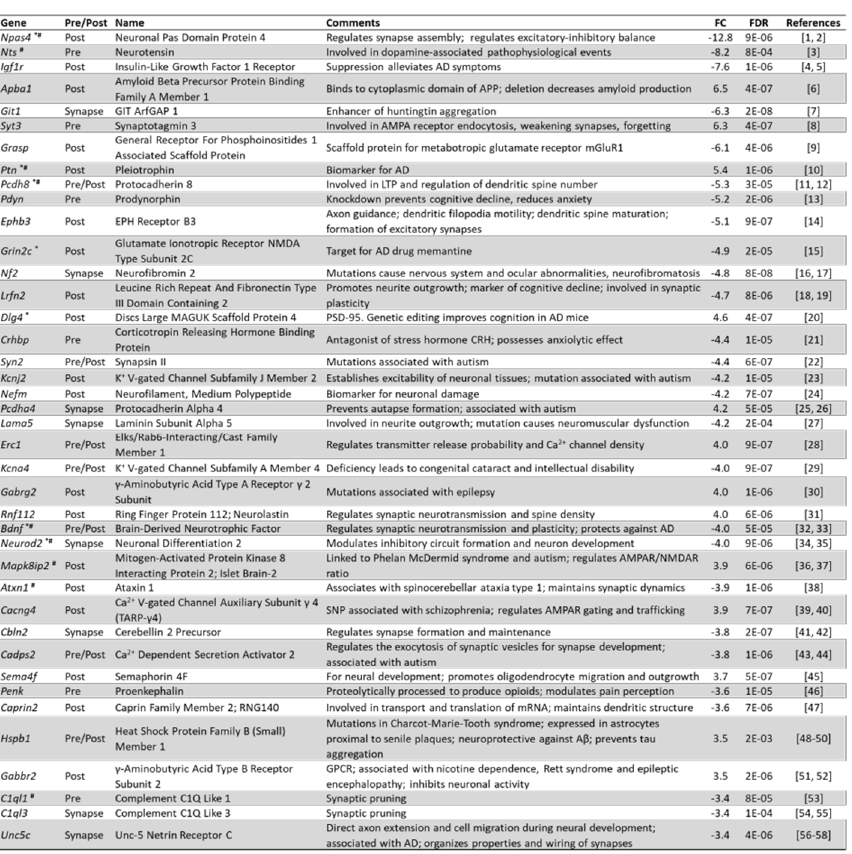
Figure 9. Synaptic genes whose expression is regulated by Arc. Shown are the top 40 synaptic genes (out of a total of 323) ranked by absolute fold change. Comments list relevant information about the function and disease association of the genes. An asterisk (*) indicates genes involved in neuroplasticity. A hashtag (#) indicates genes involved in cognition, learning and memory. APP: amyloid precursor protein; CRH: corticotropin-releasing hormone; V-gated: voltage-gated; TARP- γ 4: transmembrane AMPR regulator protein γ 4; A β : amyloid beta; GPCR: G-protein-coupled